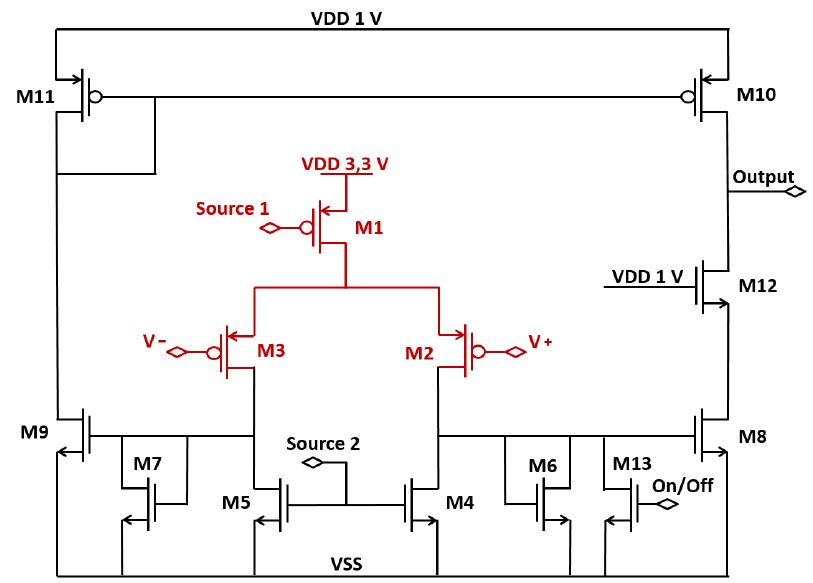
Figure 3. The two-stage operational amplifier used as a discriminator in the quenching circuit. M1–M3 are high voltage transistors (3.3 V) to sustain higher excess voltage and M4–M13 are 1 V transistor to match the subsequent